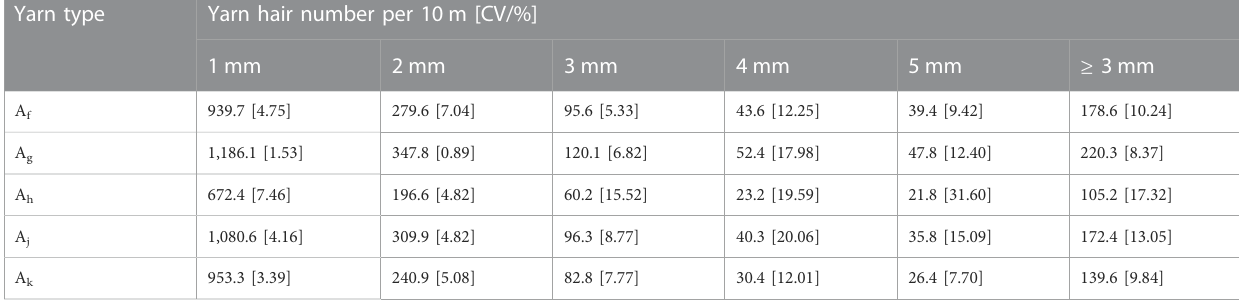
TABLE 2 Hair number comparison of different composite